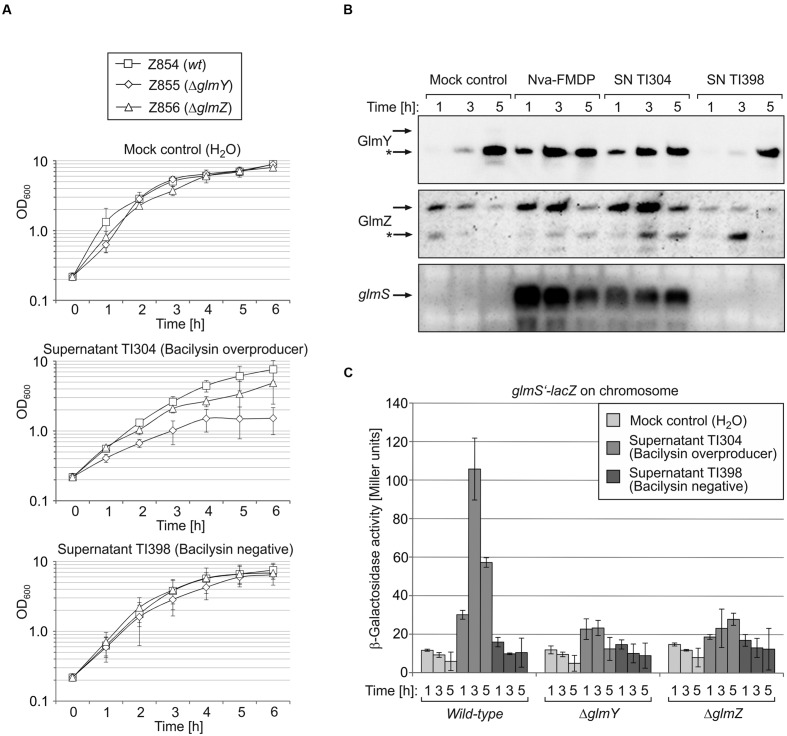
Bacilysin causes accumulation of GlmY, GlmZ and glmS RNAs in E. coli recapitulating the effects of Nva-FMDP.
E. coli strains Z854 (wild-type), Z855 (ΔglmY) and Z856 (ΔglmZ) were grown in LB supplemented either with culture supernatant (SN) of B. subtilis strain TI304 overproducing bacilysin or with SN derived from the bacilysin-negative B. subtilis mutant TI398. Cultures treated with the equivalent volume of H2O served as mock control. (A) Growth curves of the various cultures as determined by OD600 recording. (B) Northern blot analysis for detection of GlmY, GlmZ and glmS in the cultures of E. coli wild-type strain Z854. Samples for isolation of total RNA were harvested 1, 3, and 5 h after inoculation of the cultures. For comparison, a culture of strain Z854 treated with Nva-FMDP was analyzed in parallel. Loading controls are provided in Supplementary Figure S2. It should be noted that expression of glmY is generally upregulated in E. coli when entering the stationary phase (Göpel et al., 2013) explaining accumulation of GlmY in the mock control culture following 5 h of growth. However, the high GlmY levels are not transduced to glmS due to the low expression levels of GlmZ under these conditions. (C) β-Galactosidase assays monitoring expression of a glmS’–lacZ reporter fusion in the various cultures. Enzyme activities were determined from samples harvested after 1, 3, and 5 h of growth.